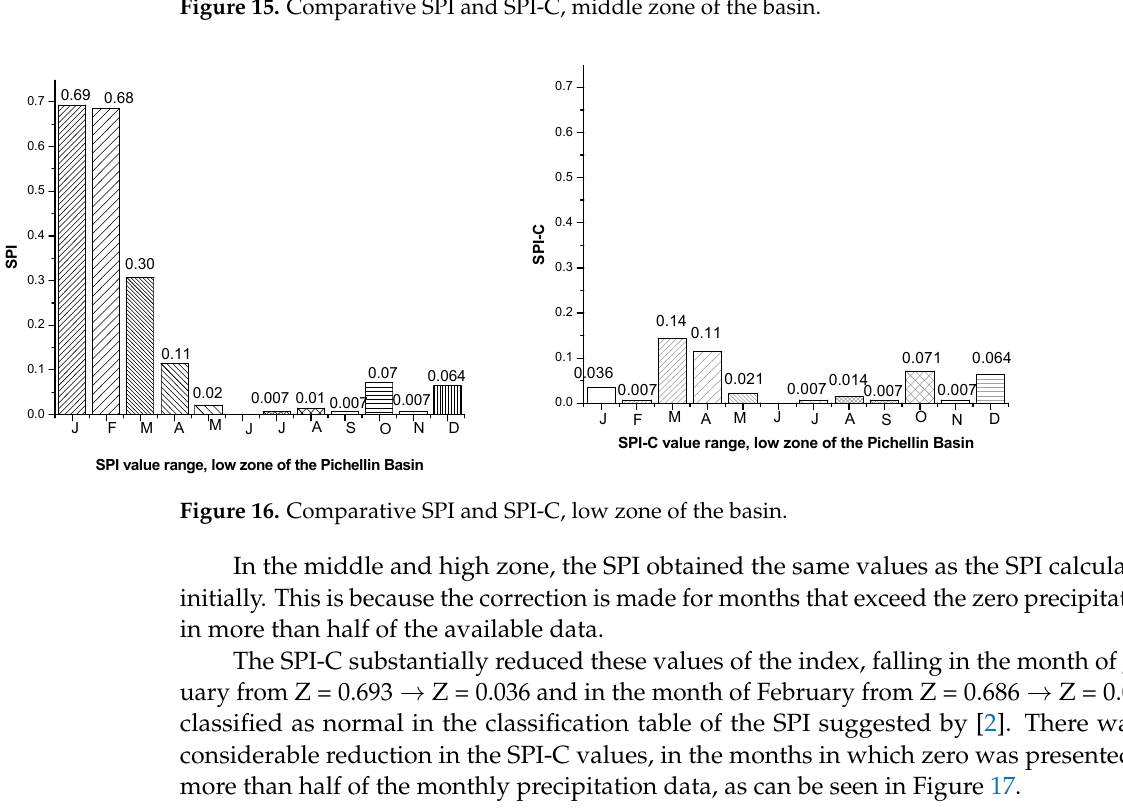
Figure 15. Comparative SPI and SPI-C, middle zone of the basin.